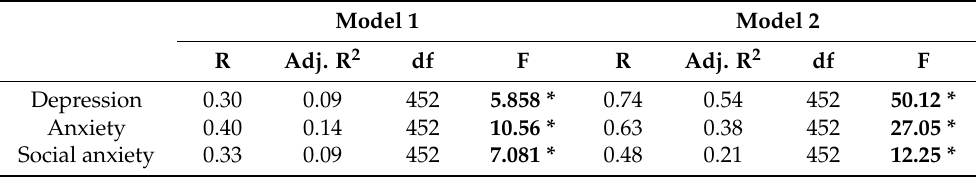
Table 4. Multiple linear regression.